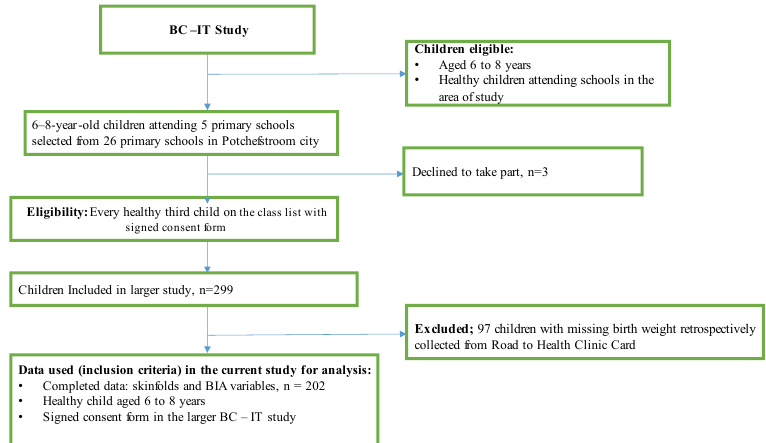
Figure 1. Flow diagram for children included in the study. Caption for Figure 1, demonstrate the procedures followed regarding the participants in the larger BC–IT study which was comprised of 299 participants. Of which in the figure, criteria’s for eligibilities and exclusion to participate in the present study show that out of 299 children 202 met the selection criteria.